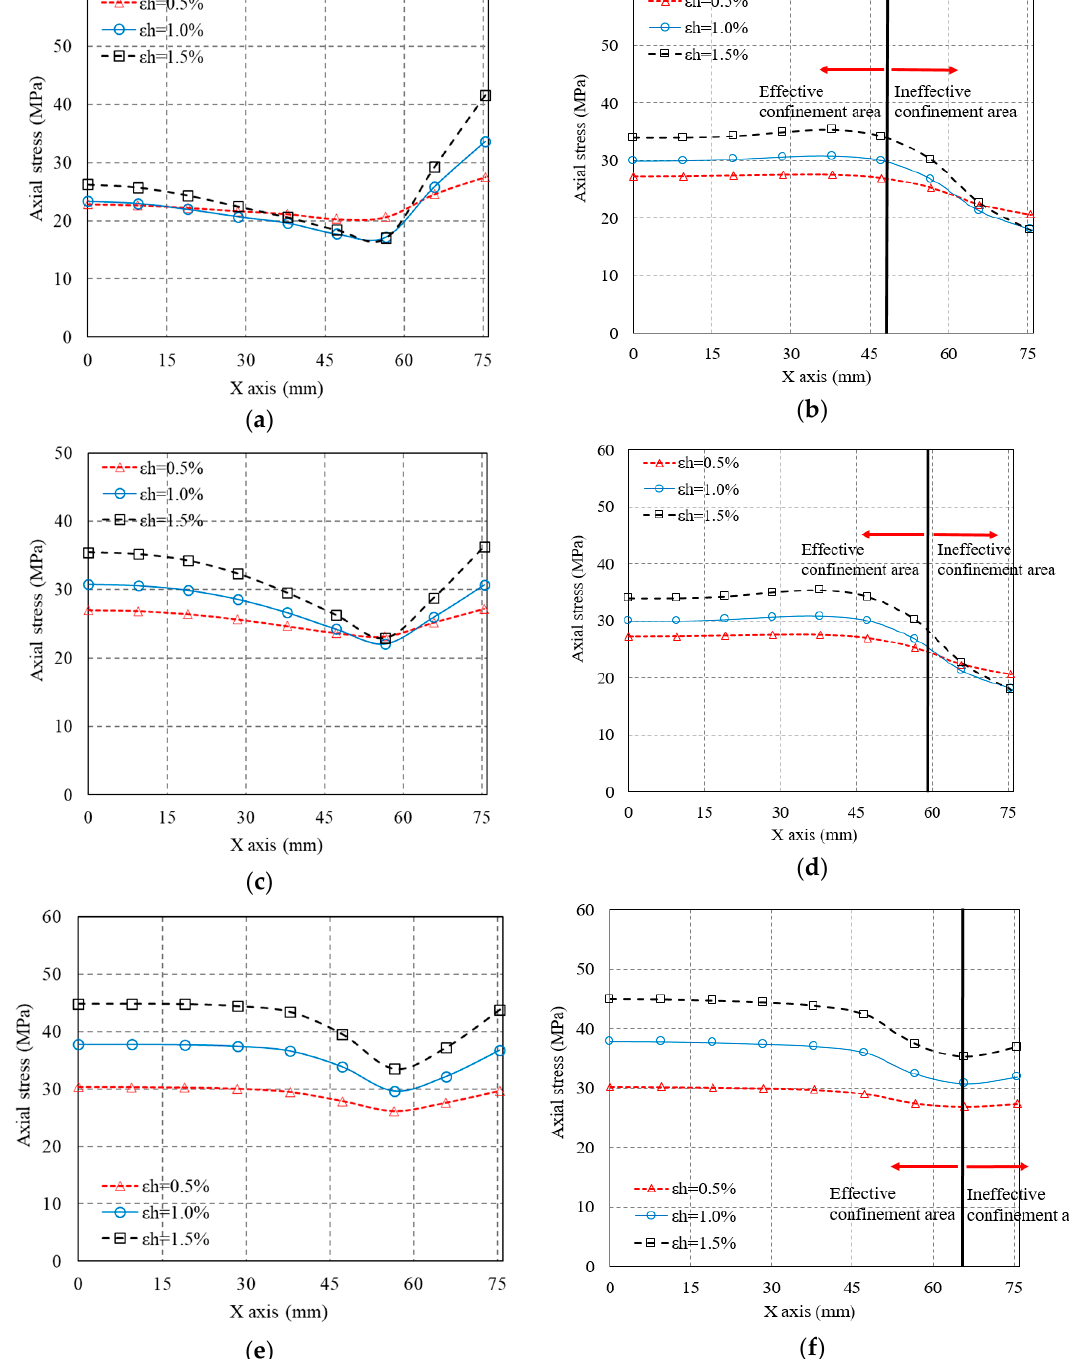
Figure 20. Axial stress distribution along the radial direction (X axis). ( a ) Mid-plain of each FRP strip (S-2-3-30); ( b ) Mid-plain of two adjacent FRP strips (S-2-3-30); ( c ) Mid-plain of each FRP strip (S-2-4-30); ( d ) Mid-plain of two adjacent FRP strips (S-2-4-30); ( e ) Mid-plain of each FRP strip (S-2-5-30); ( f ) Mid-plain of two adjacent FRP strips (S-2-5-30).